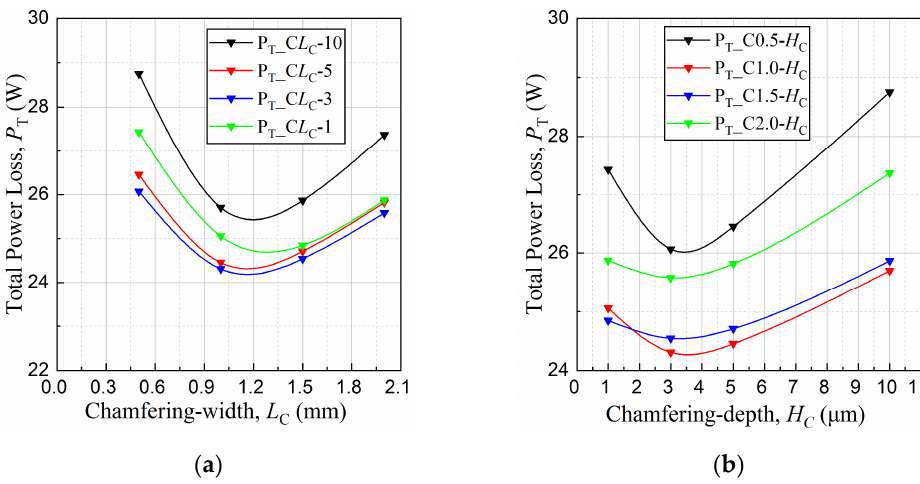
Figure 15. Under the selected working conditions, optimization, influence of micro-chamfering parameters on total power loss, where ( a ) is under the different widths ( L C ) for the same depths; ( b ) is under the different depths ( H C ) for the same widths.